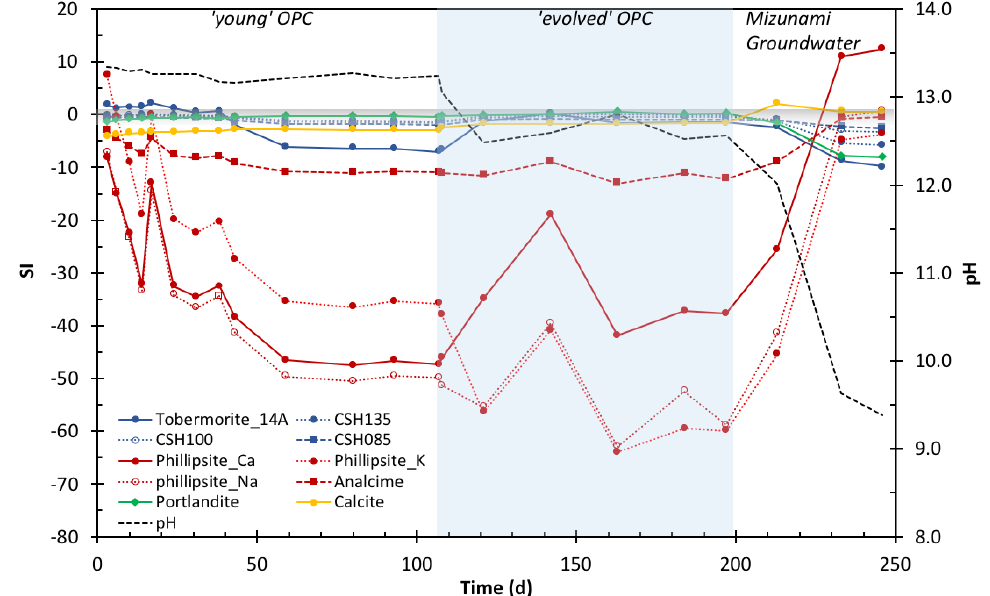
Figure 6. Selected secondary mineral saturation states in reacted fluids, experiment with ‘young’ OPC, and then the ‘evolved OPC leachate, followed by MGW; all data from Col-3. Representative C-S-H phases in blue, zeolites in red, portlandite in green, and calcite in yellow.